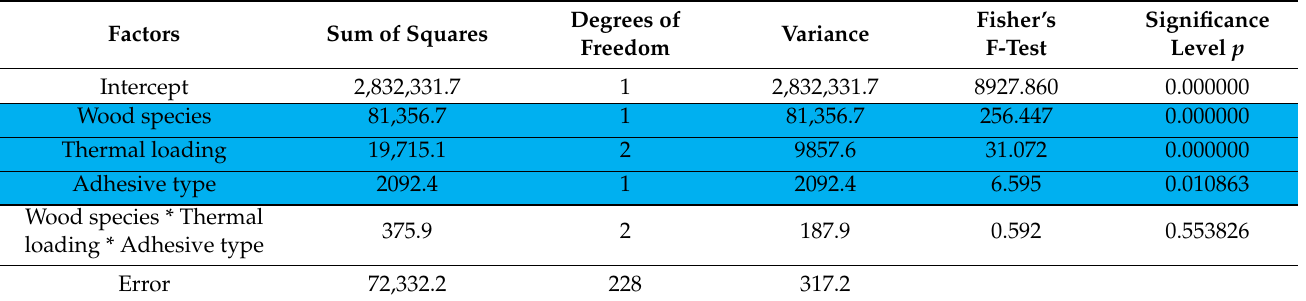
Table 3. Statistical evaluation of bending strength f m .